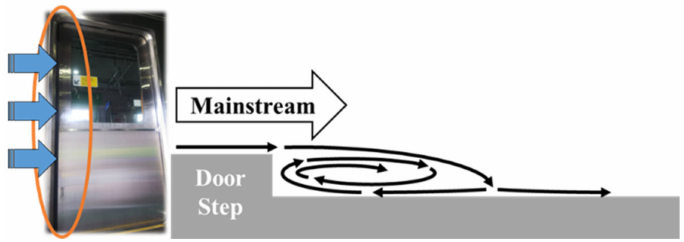
Figure 2. Modeling of flow around railcar door.